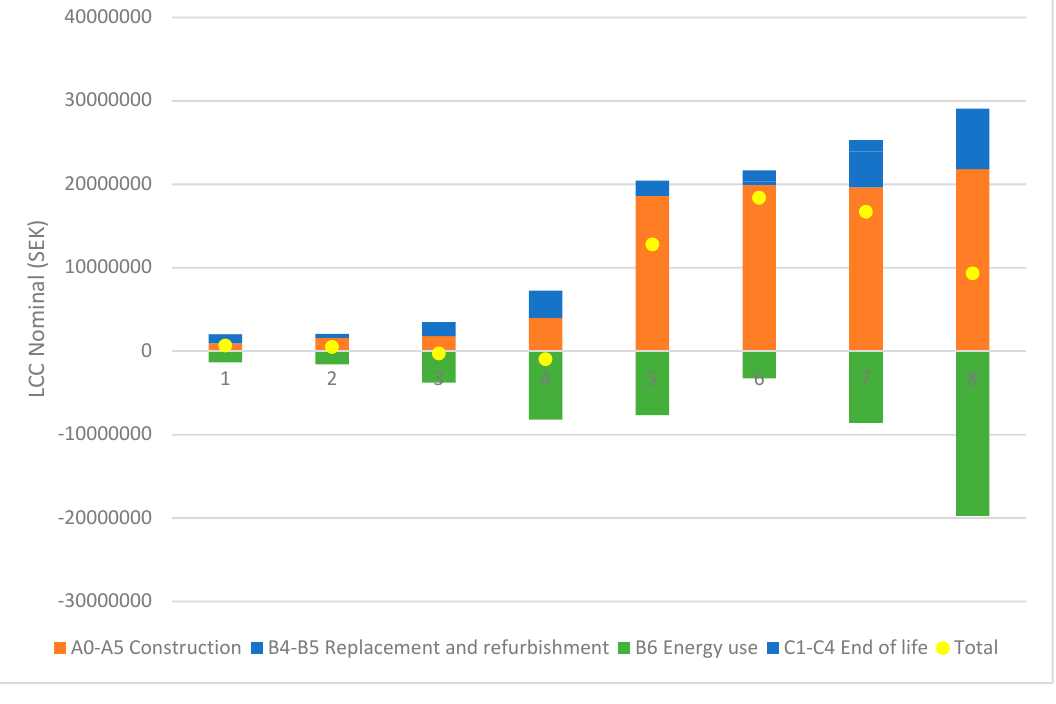
Figure 4. Nominal life cycle costs.